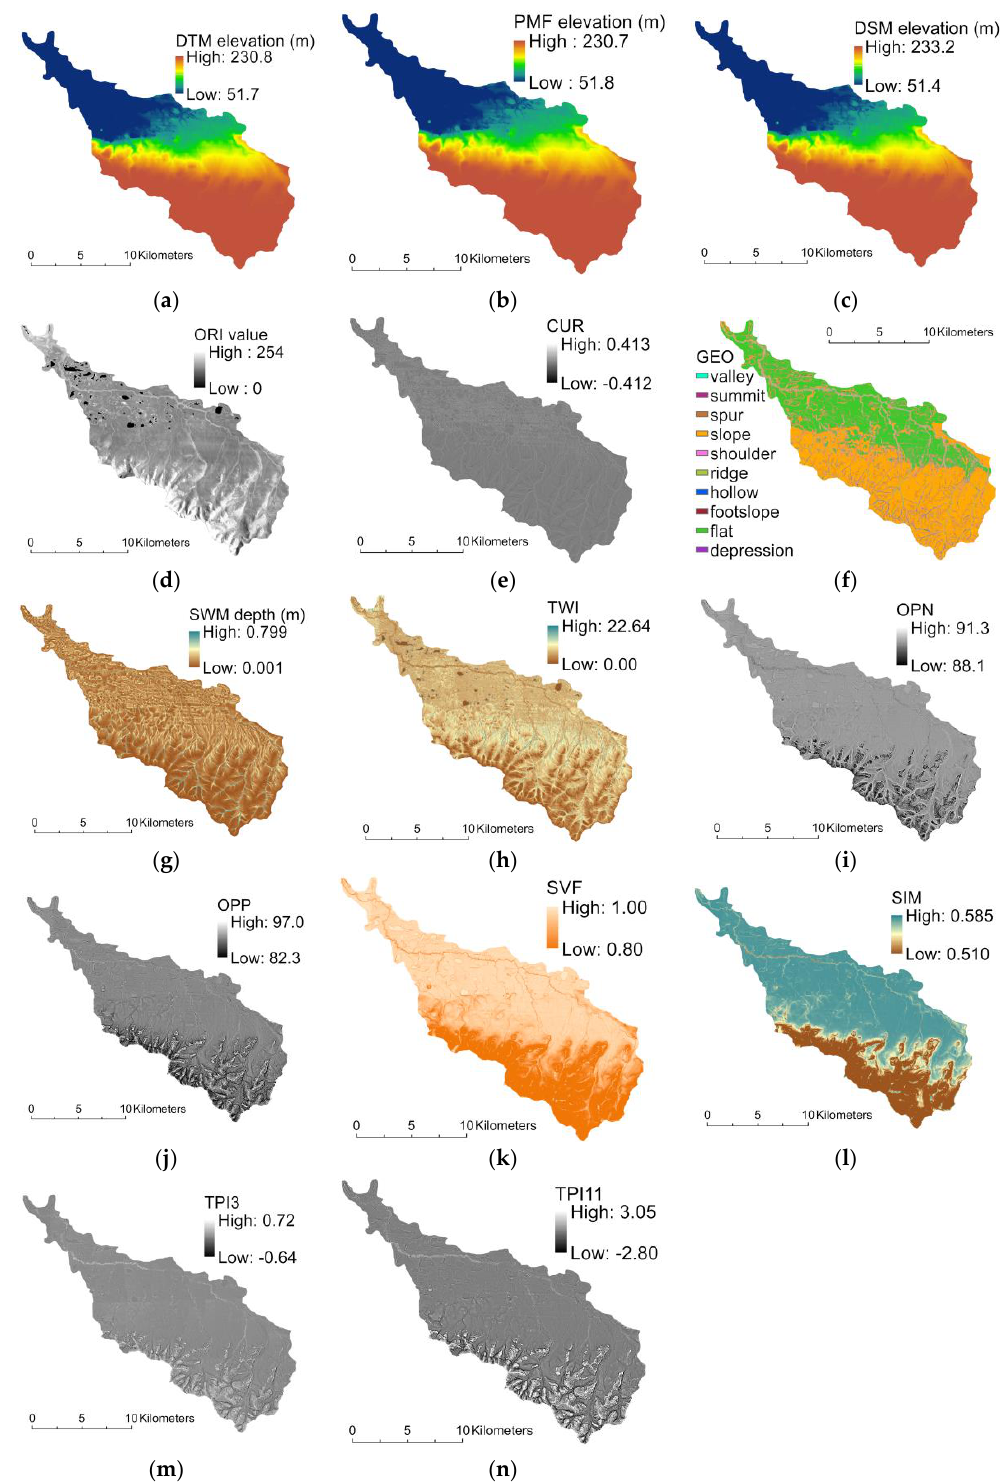
Figure 4. Fourteen input feature layers for 12-digit Hydrologic Unit (HU12) watershed 190503021300 derived from interferometric synthetic aperture radar (IfSAR) data: ( a ) Digital Terrain Model (DTM), ( b ) Perona-Malik filtered (PMF) terrain model, ( c ) Digital Surface Model (DSM), ( d ) Orthorectified Intensity (ORI), ( e ) geometric curvature (CUR), ( f ) geomorphon (GEO) landscape type, ( g ) 2-D shallow water channel depth model (SWM), ( h ) topographic wetness index (TWI) ( i ) negative openness (OPN), ( j ) positive openness (OPP), ( k ) sky view factor (SVF), ( l ) sky illumination model (SIM), ( m ) topographic position index from 3 × 3 kernel (TPI3), and ( n ) topographic position index from 11 × 11 kernel